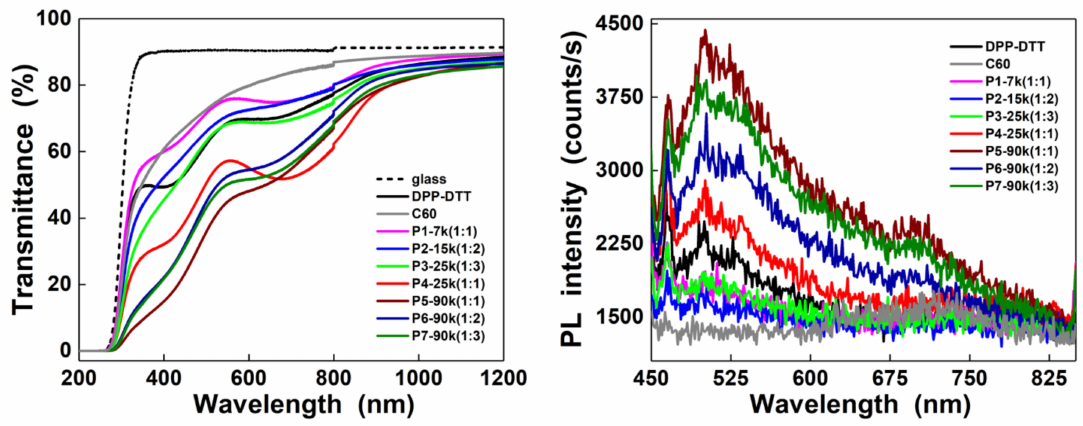
Figure 3. UV-VIS and PL spectra of the thin films deposited by MAPLE on glass and silicon,